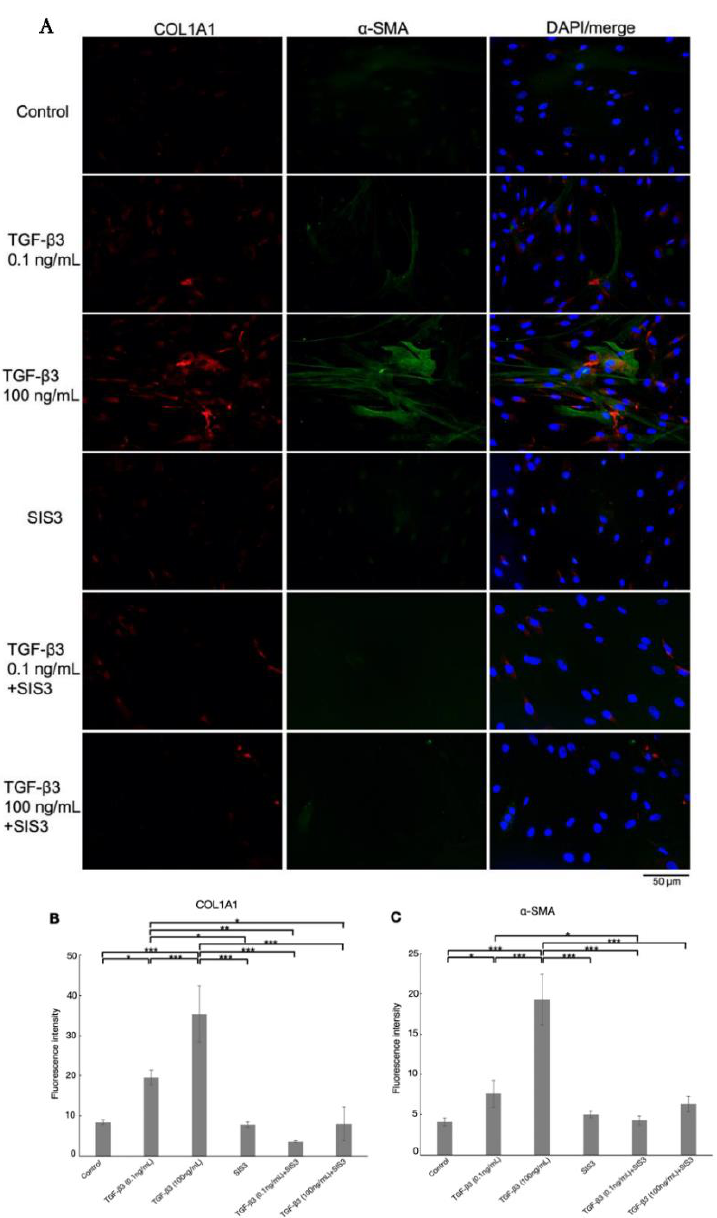
Figure 6. ( A ) Immunocytochemistry of COL1A1 and α -SMA in HTM cells treated with TGF- β 3, with or without the Smad3 inhibitor, SIS3, and ( B , C ) the quantitative results based on immunocytochemistry. The left panels show cells stained for COL1A1 (red). The middle panels show cells stained for α -SMA (green). The right panels show merged images. The levels of COL1A1 and α -SMA expression were increased with 0.1 and 100 ng/mL TGF- β3 treatment, but the changes were suppressed by cotreatment with SIS3 significantly. Data are presented as the mean ± standard deviation. * p < 0.05, ** p < 0.01, *** p < 0.001. Bar, 50 μm, n = 4.